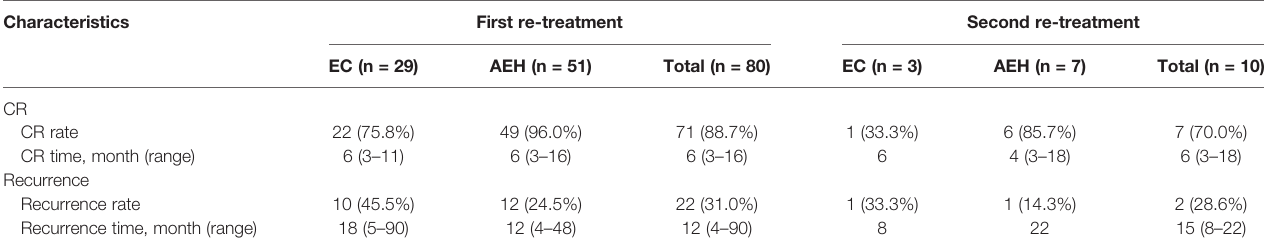
TABLE 4 | Outcome of fi rst and second re-treatment of patients.